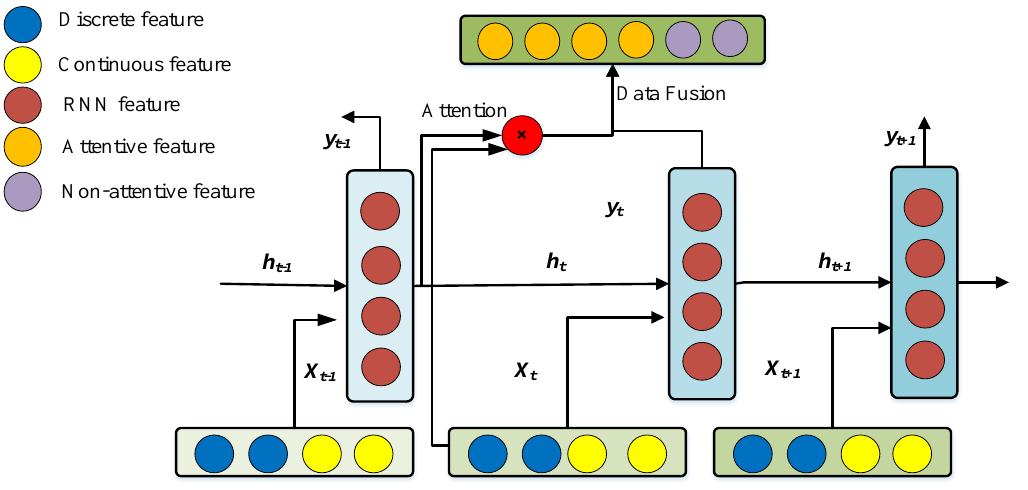
Figure 5. Illustration of the RNN and the attention model.